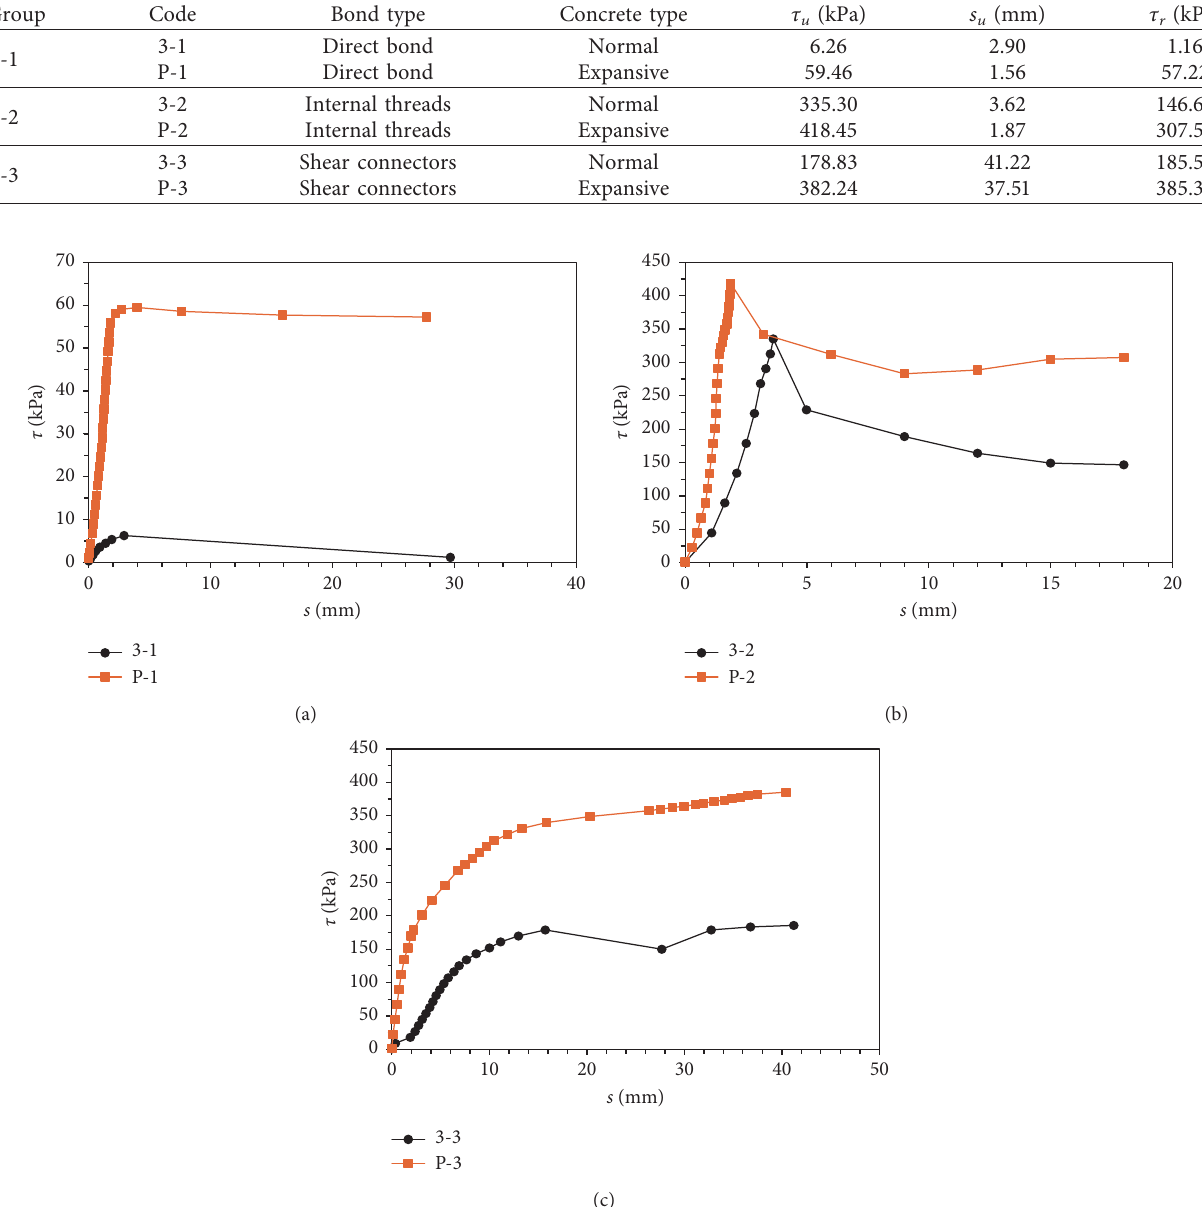
Figure 12: τ − s curves of specimens T-1, T-2, and T-3. (a) τ − s curves of Group T-1. (b) τ − s curves of Group T-2. (c) τ − s curves of Group T-3.